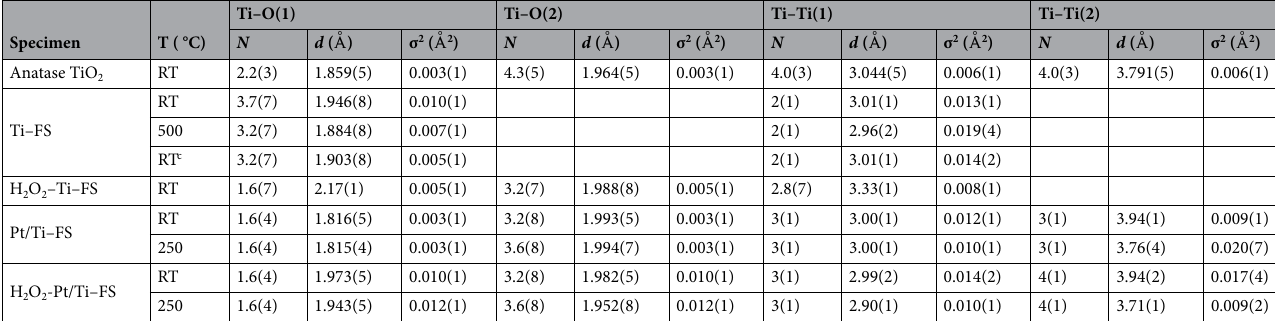
Table 3. Fit results of EXAFS data of anatase TiO 2 powder, Ti–FS, H 2 O 2 –Ti–FS, Pt/Ti–FS, and H 2 O 2 -Pt/Ti–FS at the Ti K edge. Data are shown in Fig. 4c. S 02 = 0.83 was determined by fitting the EXAFS data of the anatase TiO 2 powder and used in the other